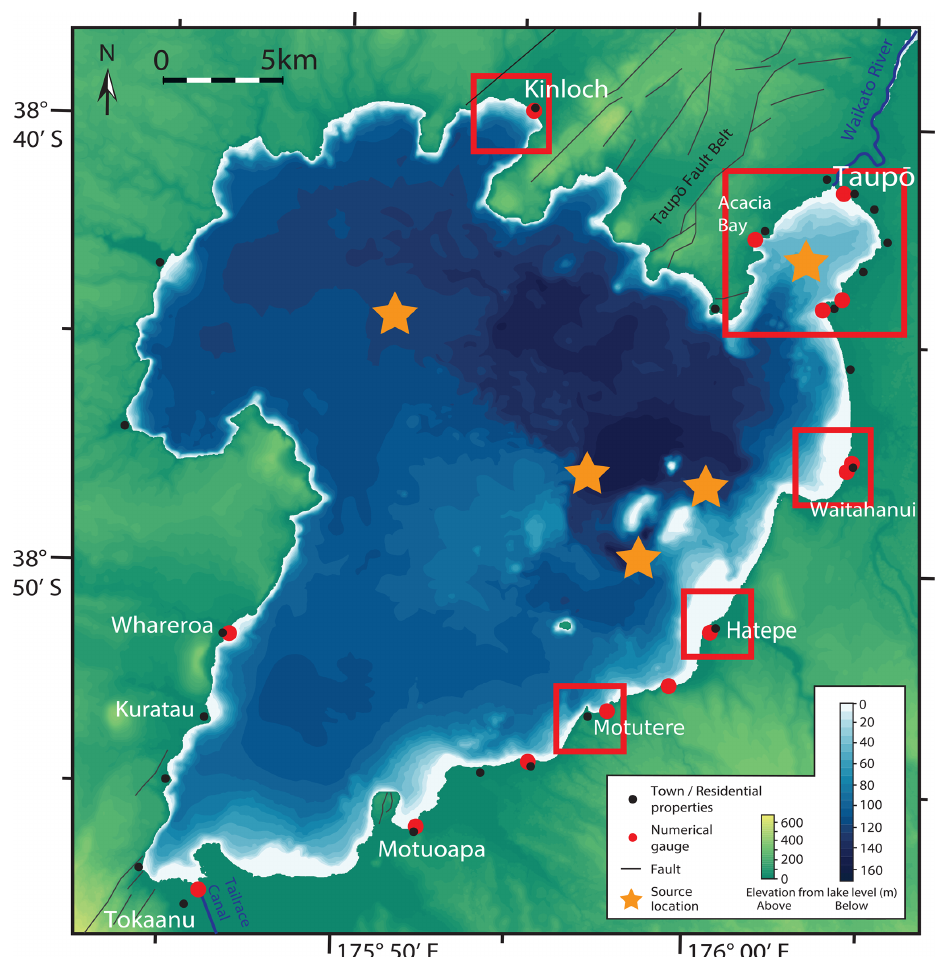
Figure 2. Illustration of the model domain and applied digital elevation model. Left: structural features including faults, elevation and bathymetry; geographical locations including settlement areas, the Waikato River and Tailrace Canal; modelling locations including discrete numerical gauge and source locations (detailed in Table 2). Right: focus regions as used in inundation mapping, Taup¯o centre (light blue),